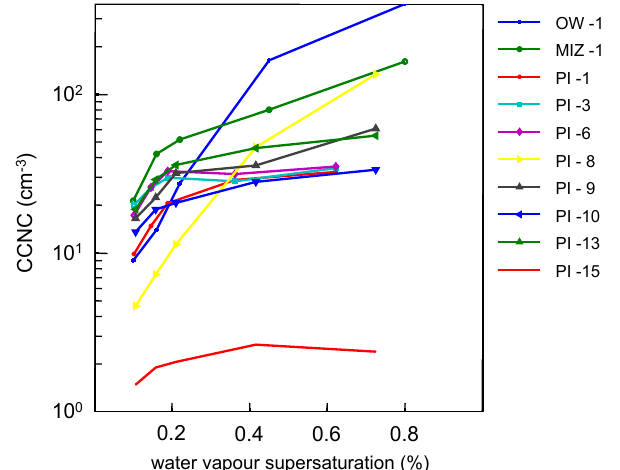
Figure 5. The measured CCNC as a function of the choice of water vapour SS (five levels between 0.1 and 0.8%) as seen by the second CCN sampler. The data are shown separately for open water (OW 1), marginal ice zone (MIZ 1) and pack ice (PI-1, 3, 6, 8, 9, 10, 13, and 15) measurements.